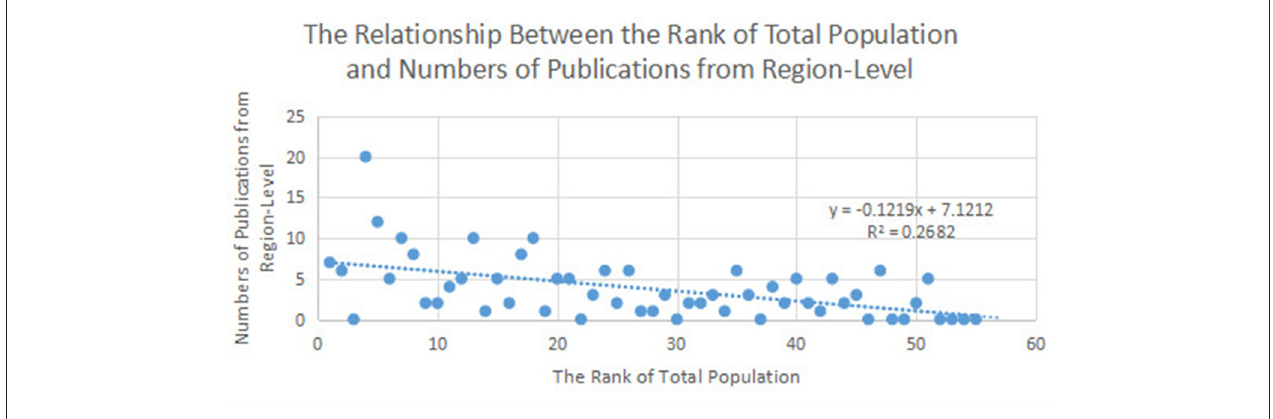
FIGURE 6 | The relationship between the rank of total population and numbers of publications from region-level.